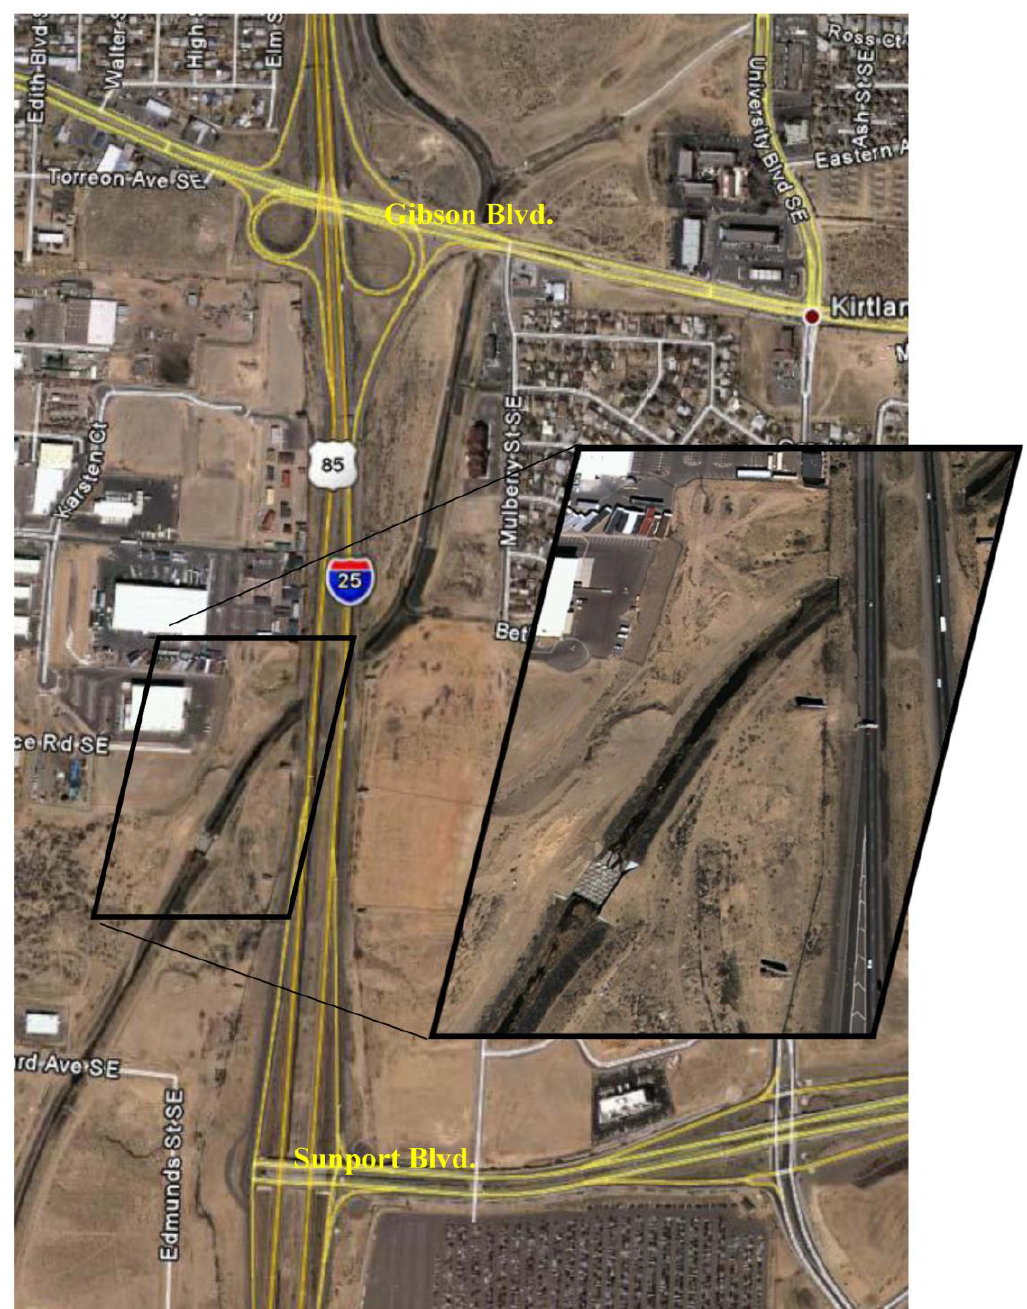
Figure 3. Image map of the project